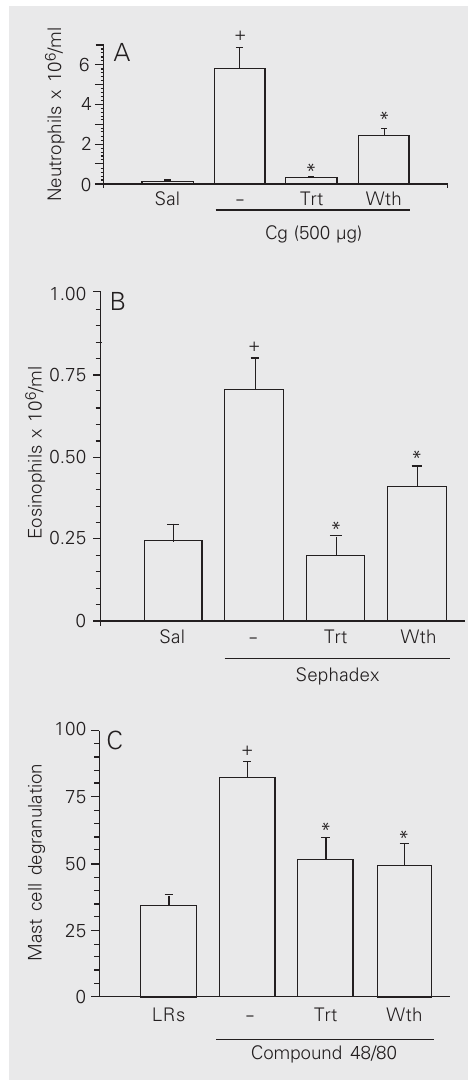
Figure 3. Effect of ethanol inhalation on carrageenan- induced neutrophil migration into a 6-day-old subcuta- neous air pouch (A), on Sephadex-induced eosinophil migration into the rat peritoneal cavity (B) and on